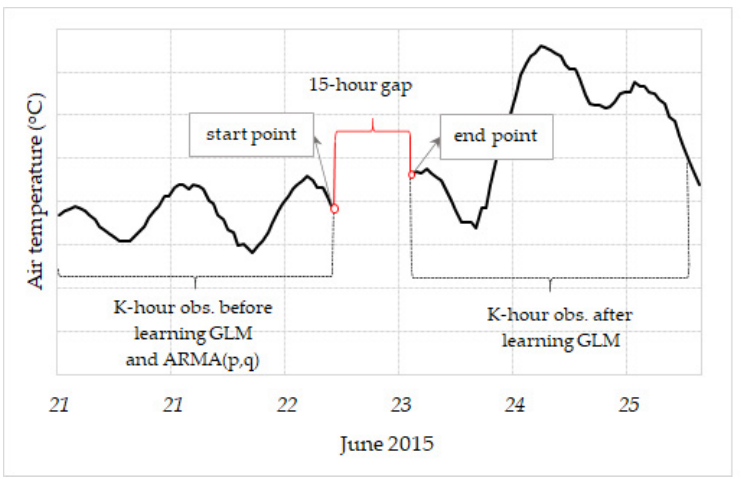
Figure 1. The main principles of trained data selection depending on the used methods. Source: authors.